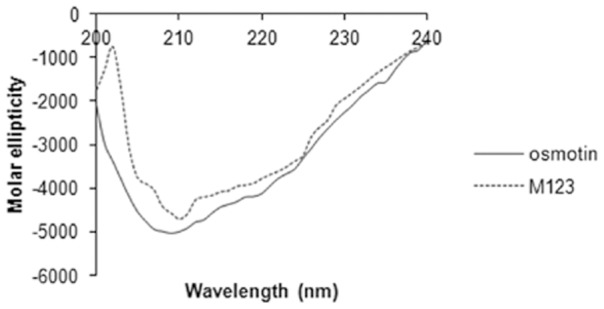
Circular dichroism analysis.Far-UV CD analysis of purified osmotin protein and M123 mutant. Results are expressed as mean residue ellipticity (y-axis) at a given wavelength (x-axis).